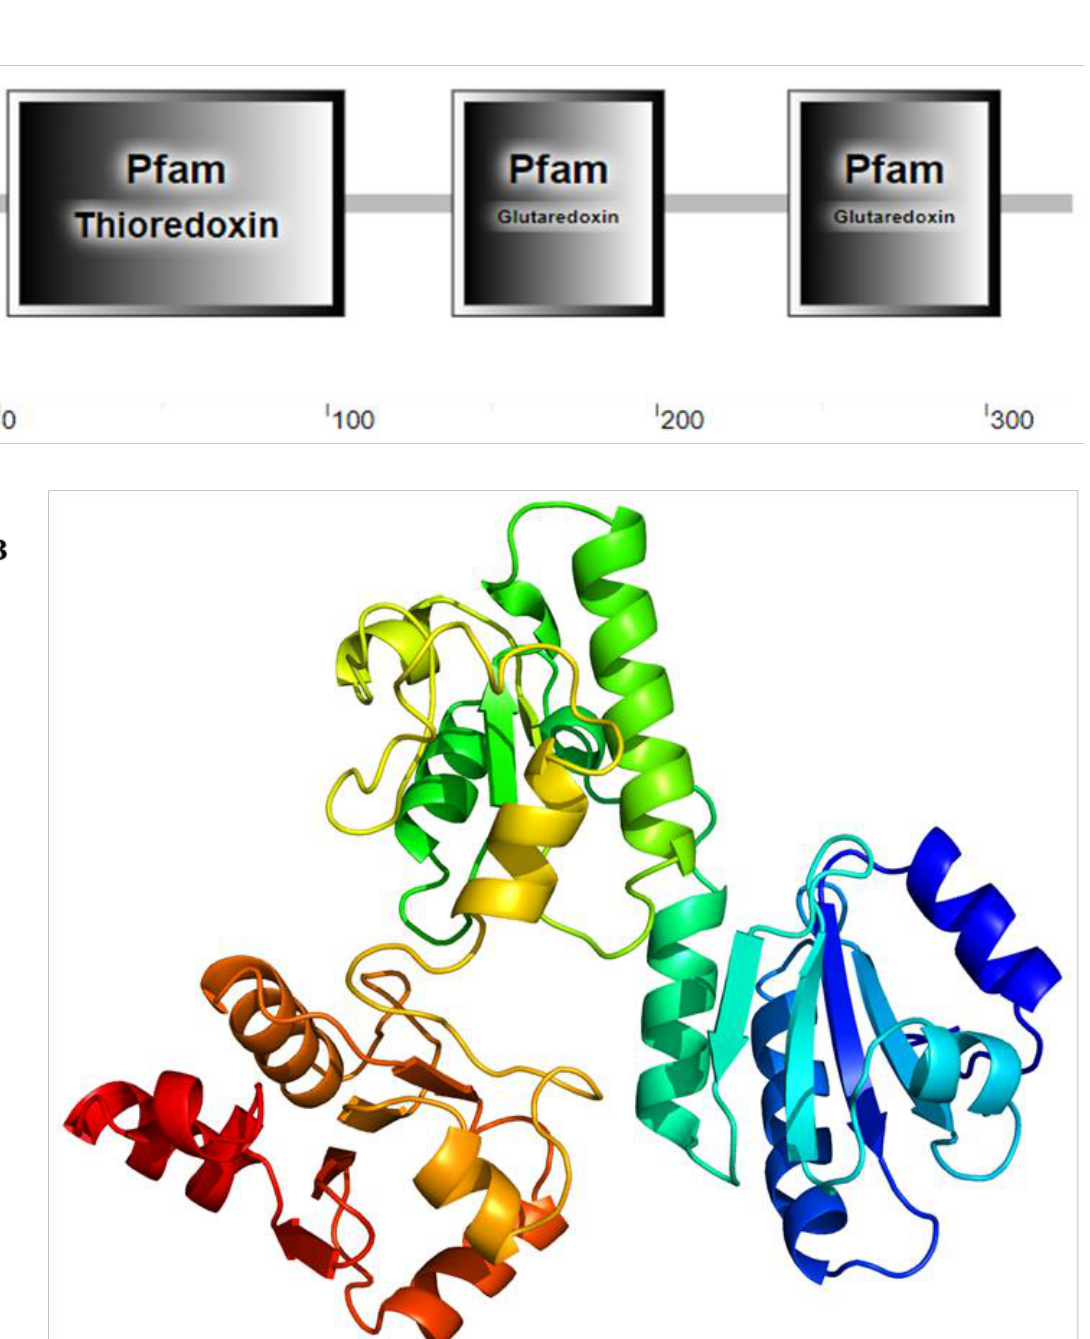
Figure 2. The deduced domain and three-dimensional structures of the SpGrx3 protein. ( A ) The deduced domain of SpGrx3 was predicted using SMART. An N-terminal thioredoxin domain and two C-terminal glutaredoxin domains were predicted. ( B ) The three-dimensional structures of the SpGrx3 protein were predicted by Phyre2 online software. The image was colored by the rainbow in the direction of the N to C termini.